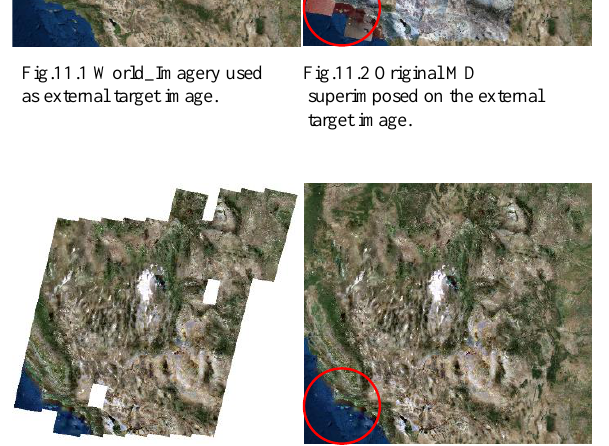
Fig.12.1 Color balance result: Fig.12.2 Color balanced mosaic Color Grid Target Model with Dataset superimposed on the external target image. external